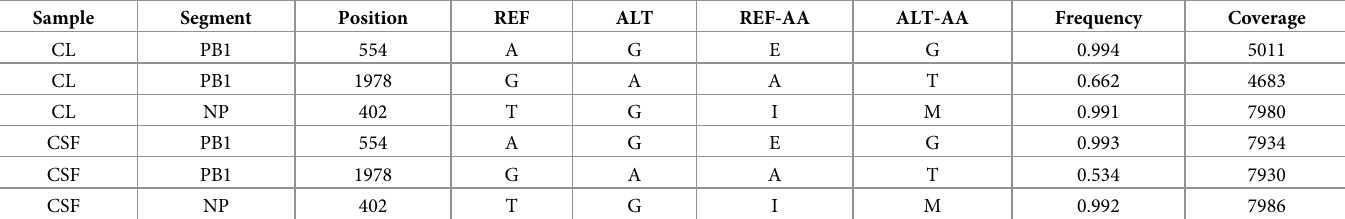
Table 1. Mutations detected in the CNS of a ferret infected with virus of the H5N1 subtype. Three substitutions were found in common between the cerebellum (CL) and cerebrospinal fluid (CSF). REF refers to the nucleotide reference; ALT to the nucleotide alternative variant; REF-AA amino acid reference; ALT-AA to substitution. Sequencing was done using MySeq Illumina